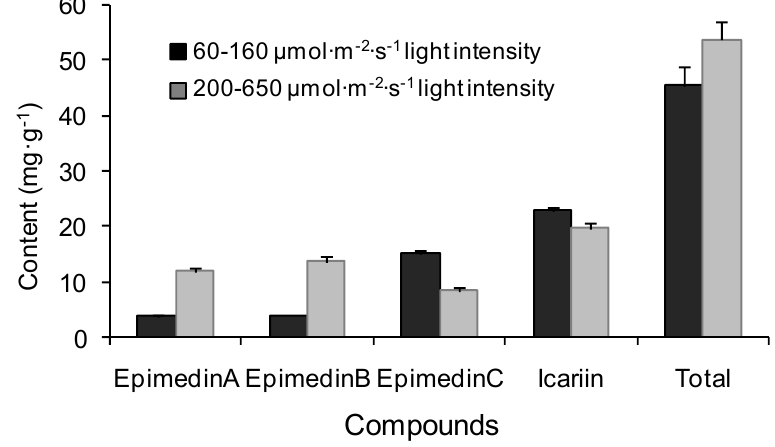
Figure 3. Contents of four flavonoids influenced by different light intensities in the common garden experiment at Wuhan Botanical Garden. Bars are standard